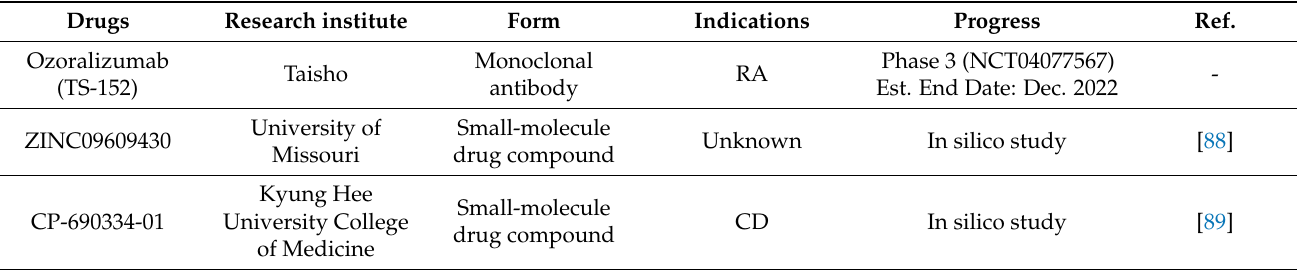
Table 2. New anti-TNF- α agents currently under development.